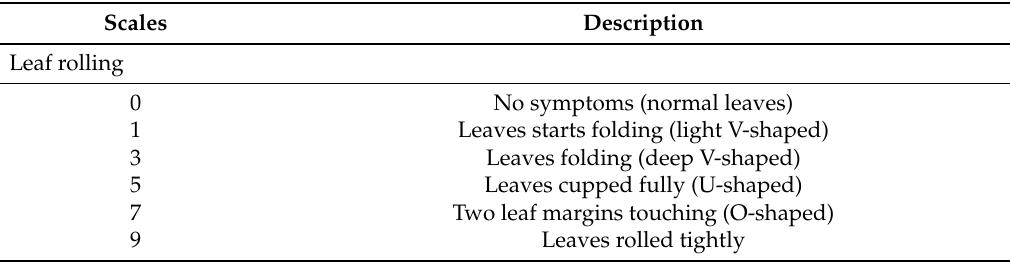
Table 2. Standard evaluation scale of drought tolerant